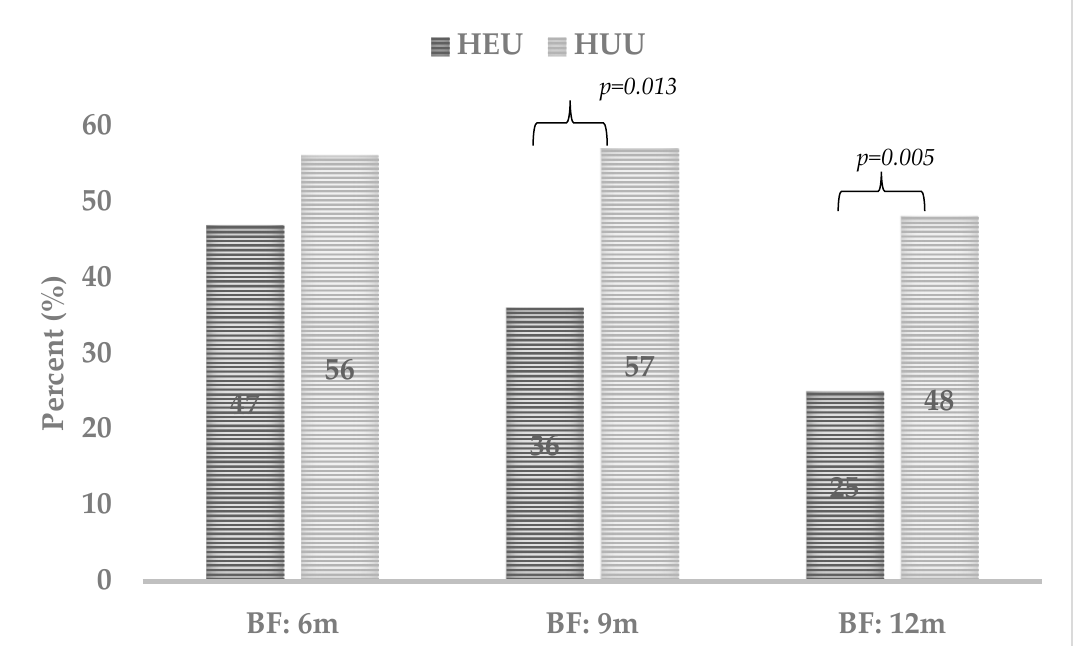
Figure 1. Infant breastfeeding practices by HIV exposure status in the first 12 months of life. Values in italic font indicate significant p -values ( p < 0.05). Abbreviations: HEU: HIV-exposed-uninfected; HUU: HIV-unexposed-uninfected. The mixed feeding category was separately calculated, and no comparison tests were performed due to one group having <5 count, which led to volatile results. Pearson’s Chi-square test was used for categorical data to determine the differences in HEU and HUU infants.